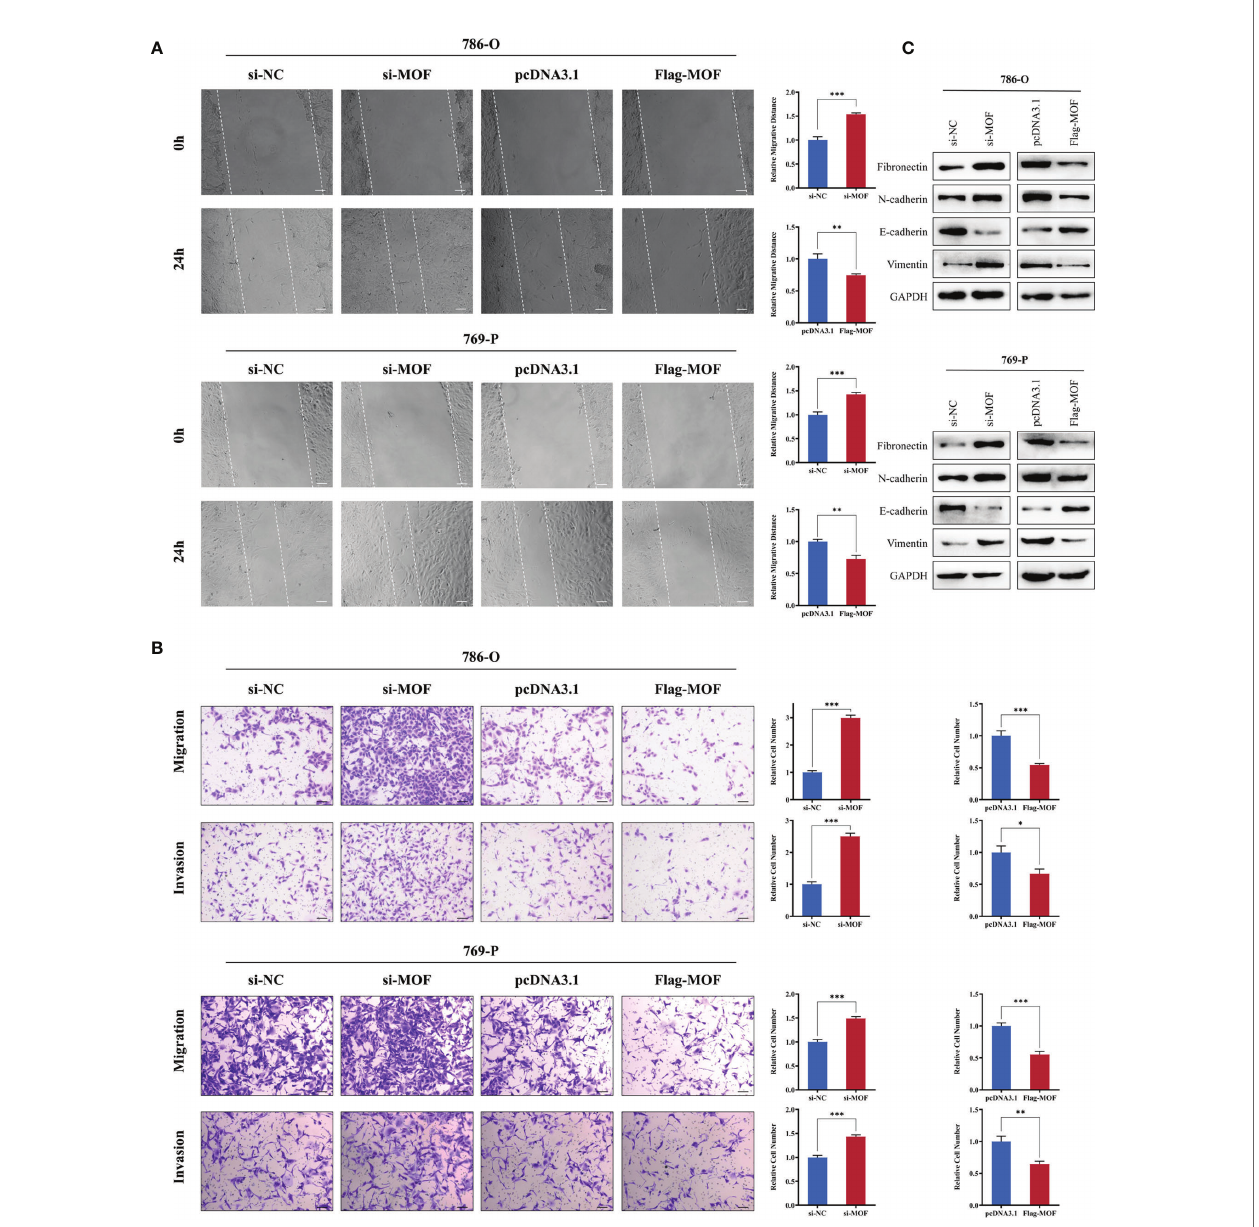
FIGURE 3 | MOF overexpression inhibits renal cell carcinoma cell migration and invasion. (A, B) The wound healing assay (A) and transwell assay (B) indicated that MOF knockdown led to inhibited renal cell carcinoma cell migration, whereas MOF overexpression caused the opposite results. Scale bar, 100 m m. (C) Western blot was used to detect the effect of MOF on the expression of EMT markers. (*, p < 0.05, **, p < 0.01, ***, p <